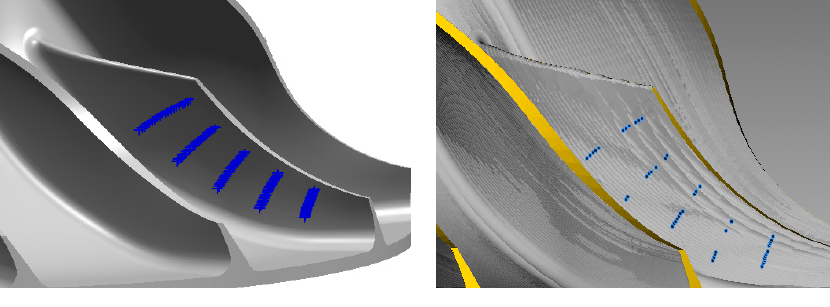
Figure 4. Impeller model diagram.